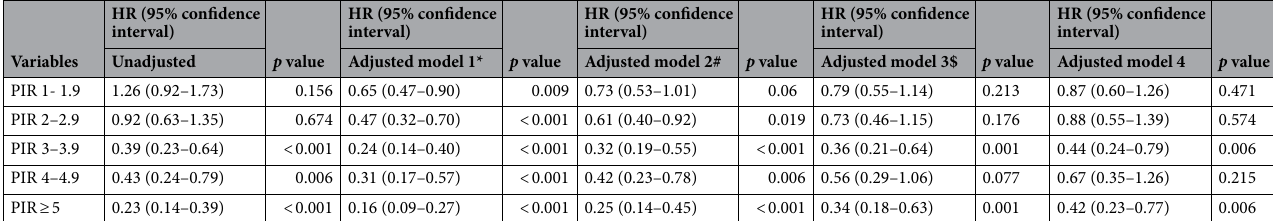
Table 5. Hazard ratios (95% confidence intervals) for the risk of cardiac mortality stratified by PIR Categories. *Models are adjusted for age, sex and race/ethnicity. # Models are adjusted for age, sex, race/ethnicity, citizen status, marital status, education status and insurance (yes or no, not the types). $ Models are adjusted for age, sex, race/ethnicity, citizen status, marital status, education status and insurance (yes or no, not the types), diabetes mellitus, hypertension, smoker, obesity, dyslipidemia. ¶ Models are adjusted for age, sex, race/ethnicity, citizen status, marital status, education status and insurance (yes or no, not the types), diabetes mellitus, hypertension, smoker, obesity, dyslipidemia, CAD, CHF and